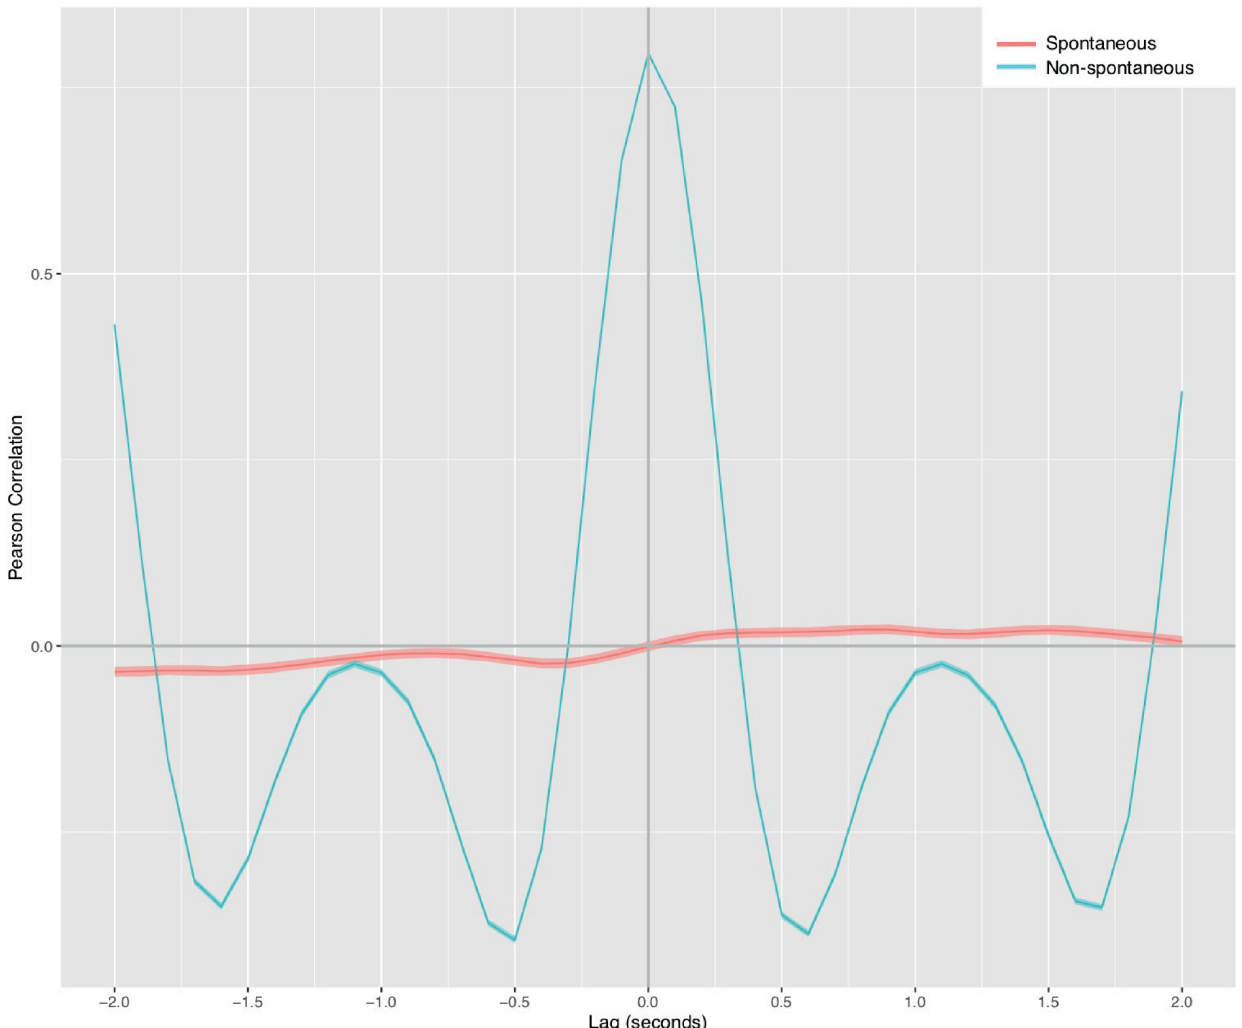
Fig 3. Cross-correlation curves for spontaneous and nonspontaneous interactions. The colored area surrounding the curve indicates the confidence interval. Negative lag times in the plot correspond to adult lagging behind the infant, i.e., the adult’s reactions to the infant. Conversely, positive lag times correspond to the infant’s reactions to the unknown adult. Data have been organized so that positive correlation values indicate to mirror-like coordination between the interactants. Conversely, negative correlation values correspond to anatomical coordination between interactants.